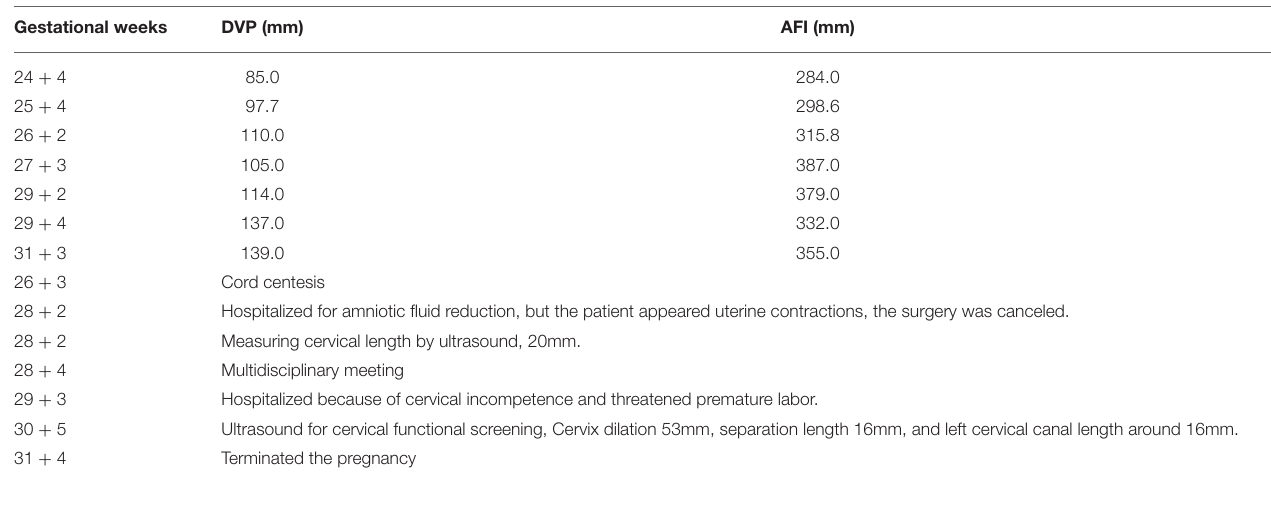
TABLE 1 | The timeline of the pregnant woman ultrasound results and other